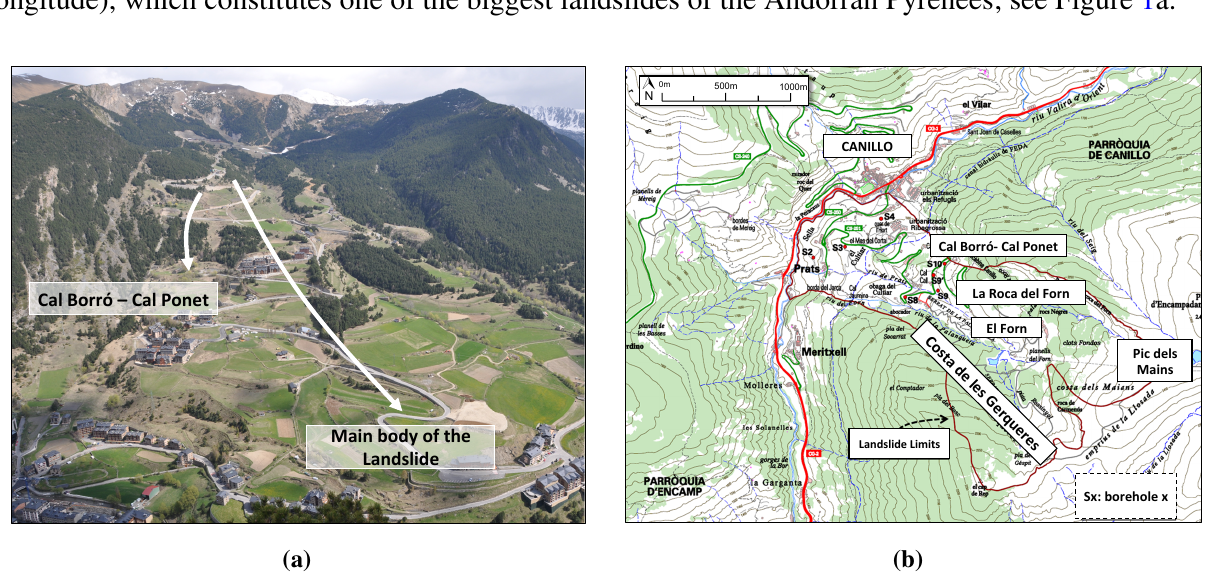
Figure 1. ( a ) General overview of the landslide of El Forn de Canillo; ( b ) landslide limits and location of the in-field monitoring network installed (Points S2 to